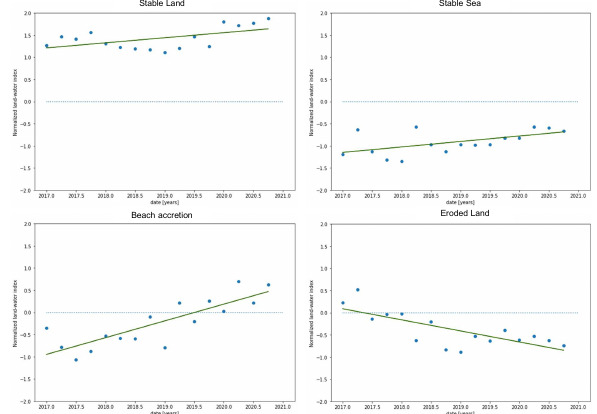
Figure 7. Linear regression for single pixels belonging to different groups. Each point in the time series is the NLWI resuming the pixel state for a whole season. In the two squares above represent stable areas. The lower squares represent two dynamic pixels that mutates the land-cover.